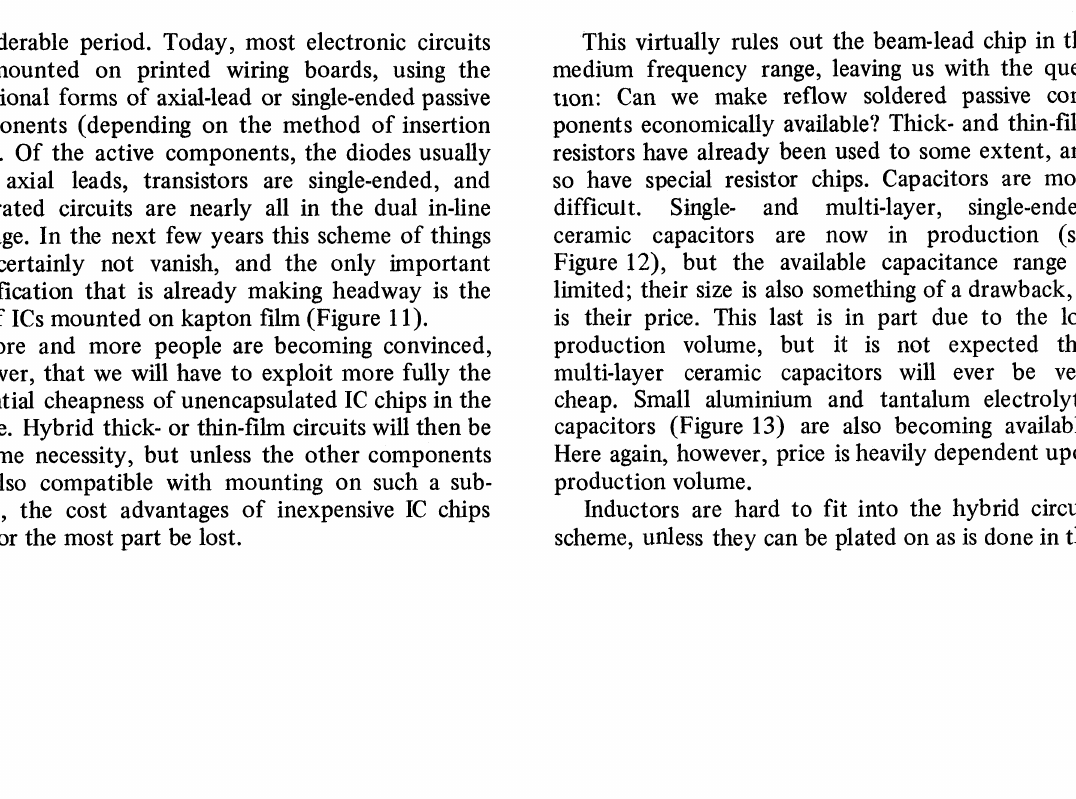
FIGURE 11 Integrated circuit on polyimid film, mounted on a ceramic substrate (Approx.